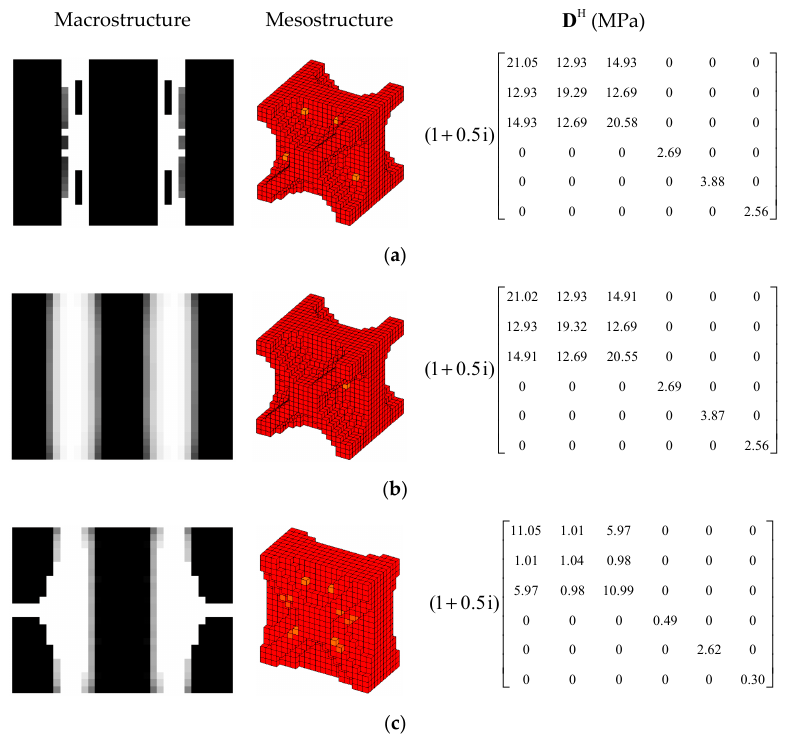
= 0.8 and Figure 23. Design results for maximizing the first modal loss factor: ( a ) Case 1: f